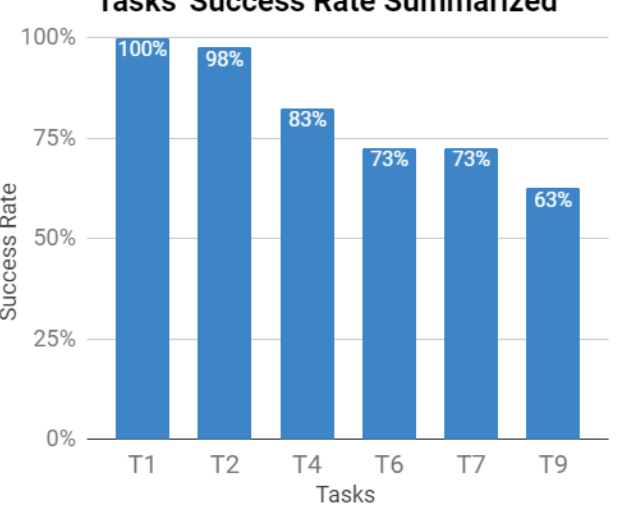
Figure 9. Summary of success rate in the practical tasks performed by remote users. Answers were asked for tasks listed in the questionnaire shown in Table I in the Appendix.